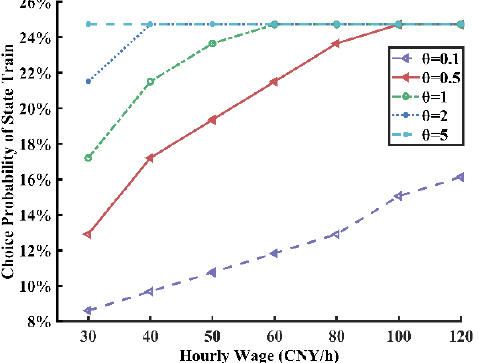
Figure 17. Sensitivity analysis of hourly wages to state train choice probability of suburban passengers at station No. 8 (Current train No. 8: State).